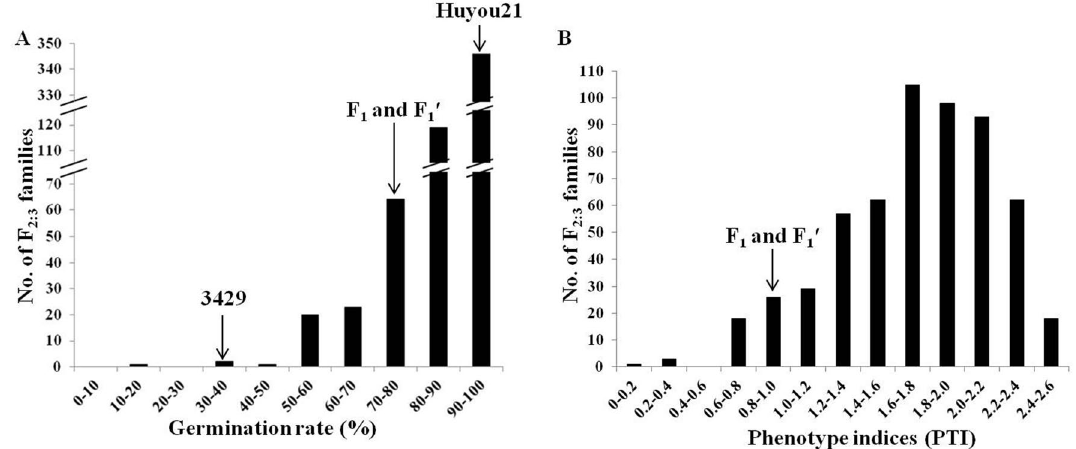
Figure 1. Distribution of the LTG phenotype in F 2:3 population four days after imbibition (DAI) at 8 ℃ .